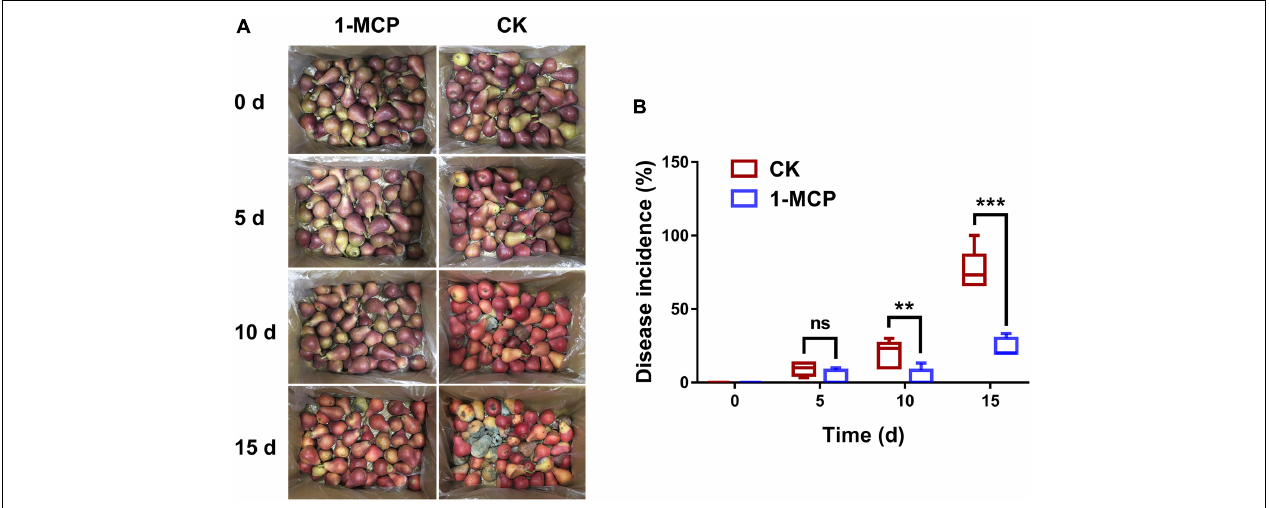
FIGURE 1 | Pear ( Pyrus communis L.cv. “Doyenne du Comice”) fruit decay was reduced by 1.0 µ l L − 1 1-methylcyclopropene (MCP) during storage. (A) Symptoms of pear decay during storage. (B) Disease incidence of pear fruit during storage. The disease incidence rate was calculated using the formula as the number of fruits with visible disease spots/the total number of fruits × 100. Each treatment had five replicates. The asterisk represents the significance between the different treatments (** p < 0.01; *** p < 0.001).